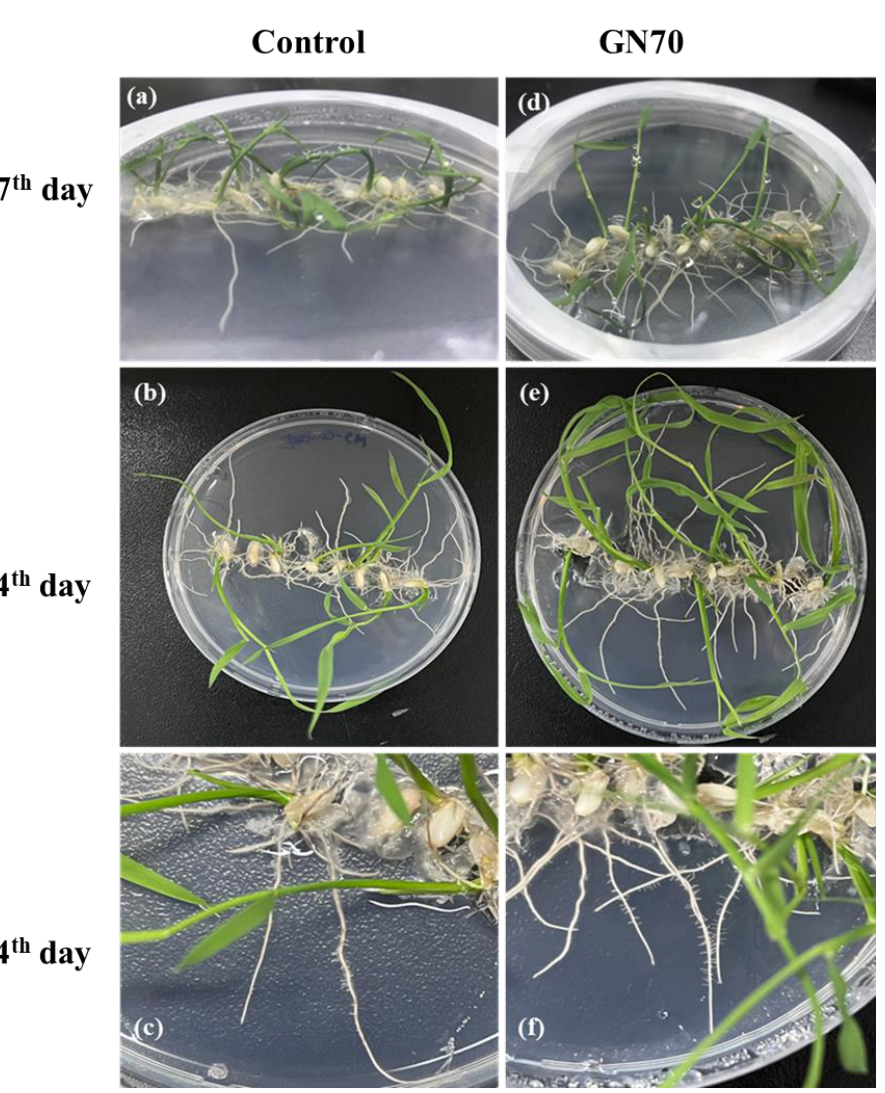
Figure 2. Effects of Arthrobacter sp. GN70 inoculation on the growth of rice seedlings after 7 and 14 days of incubation. ( a – c ) representative images of seedlings growing on control plates; ( d – f ) are seedlings inoculated with GN70. The experiment was repeated three times. Figure ( c , f ) show the comparison of lateral root development.